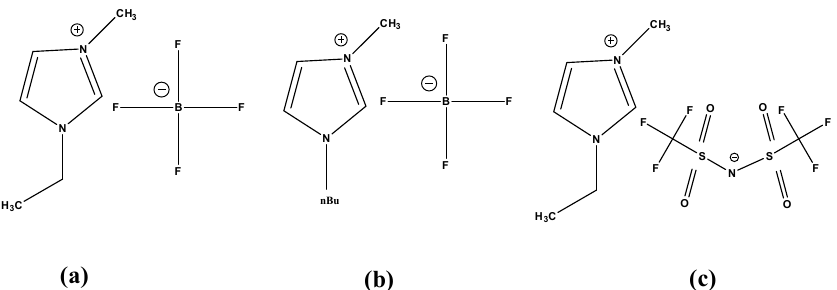
Figure 1. ( a ): 1-Ethyl-3-methylimidazolium tetrafluoroborate [EMIM][BF 4 ], ( b ): 1-butyl-3-methylimidazolium tetrafluoroborate [BMIM][BF 4 ] and ( c ): 1-ethyl-3-methylimidazolium bis (trifluoromethylsulfonyl) imide [EMIM][TF 2 N]. The physical properties of these three RTILs are described in Table 1. Table 1. Conductivity and electrochemical stability of the room-temperature ionic liquids (RTILs) under investigation. RTIL Conductivity